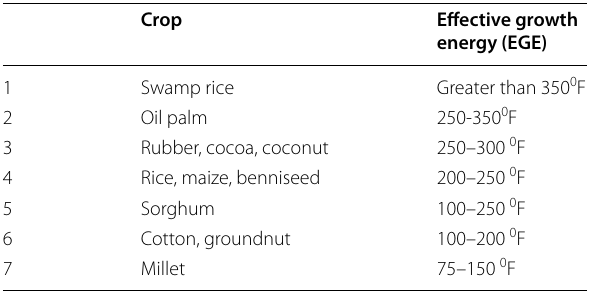
Table 11 Temperature requirement for some selected crops